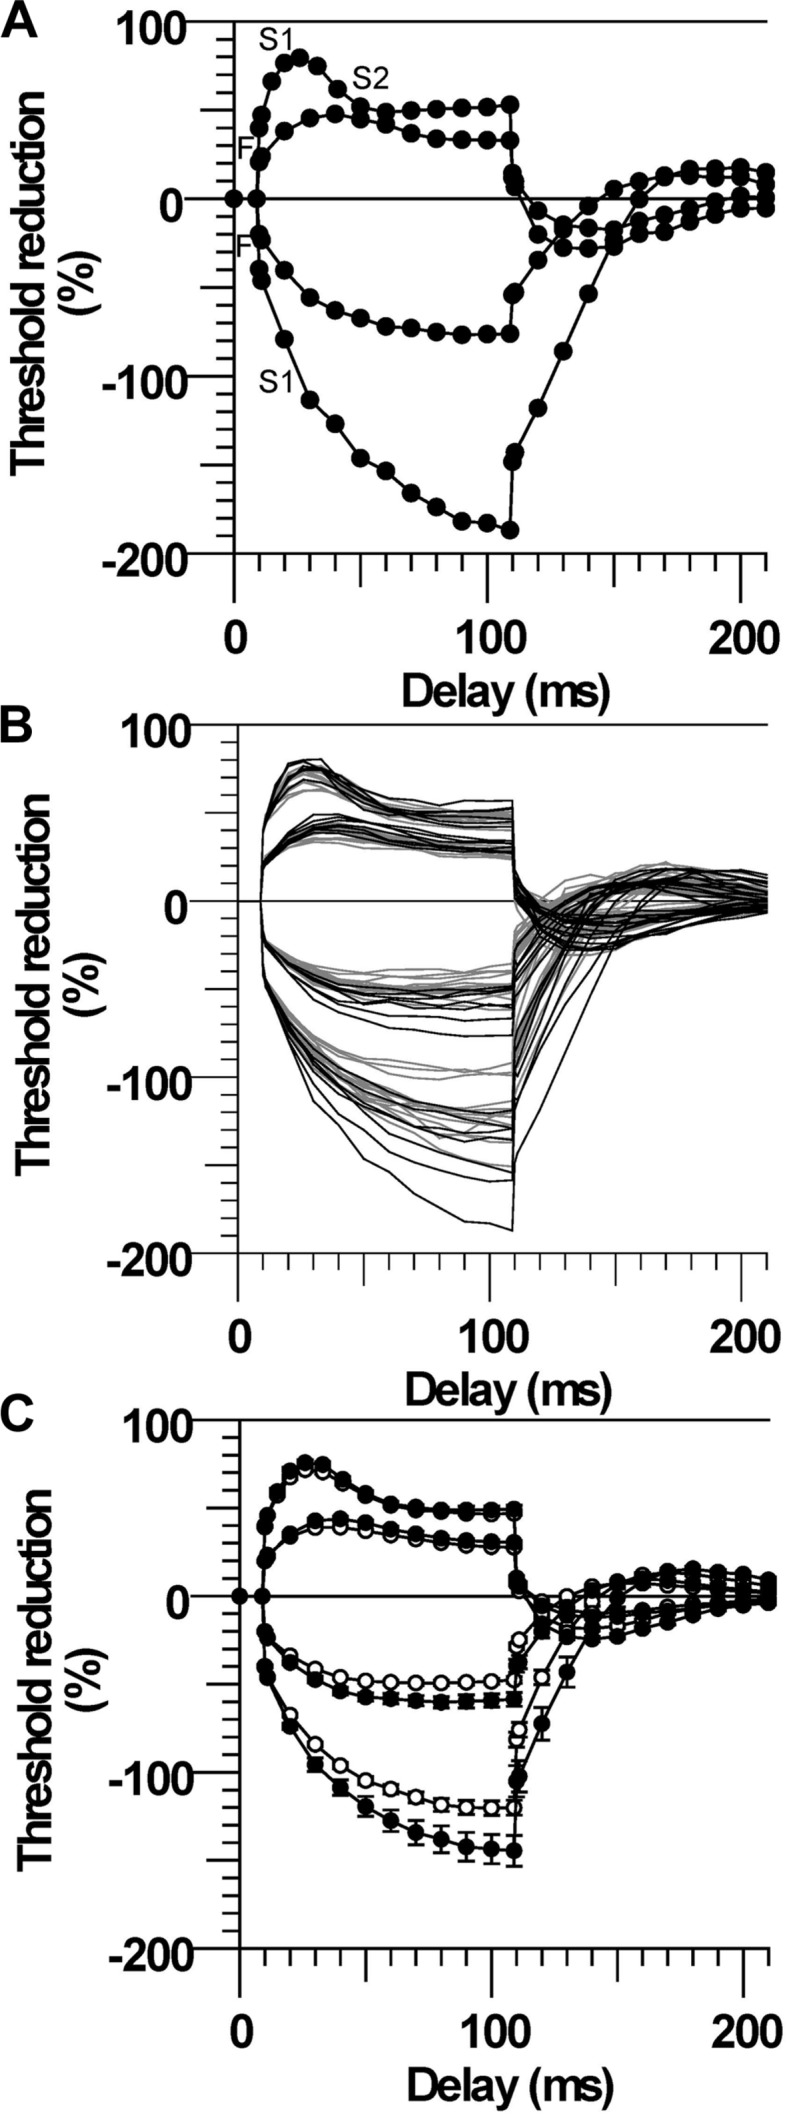
Larger threshold electrotonus in cerebral palsy (CP). (A) Threshold changes during 100 ms ±20 and ±40% threshold currents in one CP subject (number 2). The different phases of electrotonus (F, S1, and S2) are noted for the ±40% threshold responses. (B) Responses of all CP (black lines) and control (gray lines) subjects. (C) Mean (±SE) responses demonstrating the larger changes in early and late threshold electrotonus (“fanning out”) in CP (filled symbols) compared to control subjects (unfilled symbols).